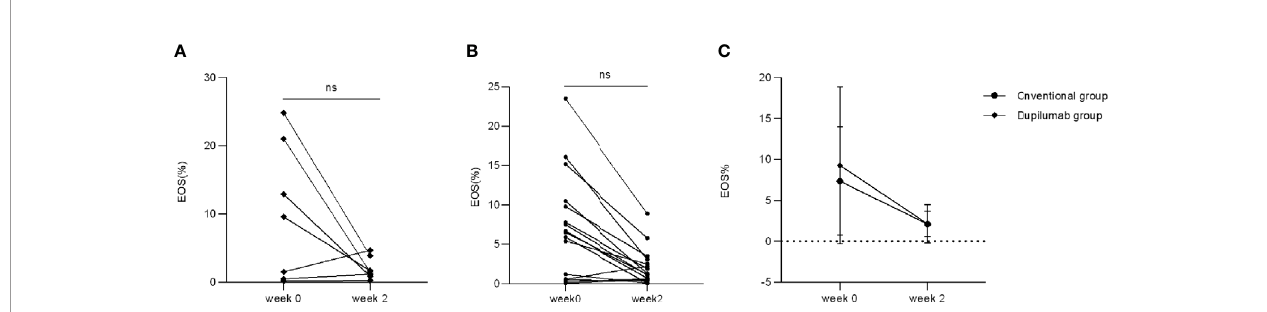
FIGURE 5 | Comparison of EOS% between two treatment groups. EOS% has decreased to varying degrees from weeks 0 to 2 in the dupilumab group (A) (ns, not signi fi cance; p > 0.05 by Mann-Whitney U test) and the conventional group (B) (ns, not signi fi cance; p > 0.05 by Mann-Whitney U test). (C) Comparison of improvement in EOS% in both groups ( p > 0.05 by two-way RM ANOVA).